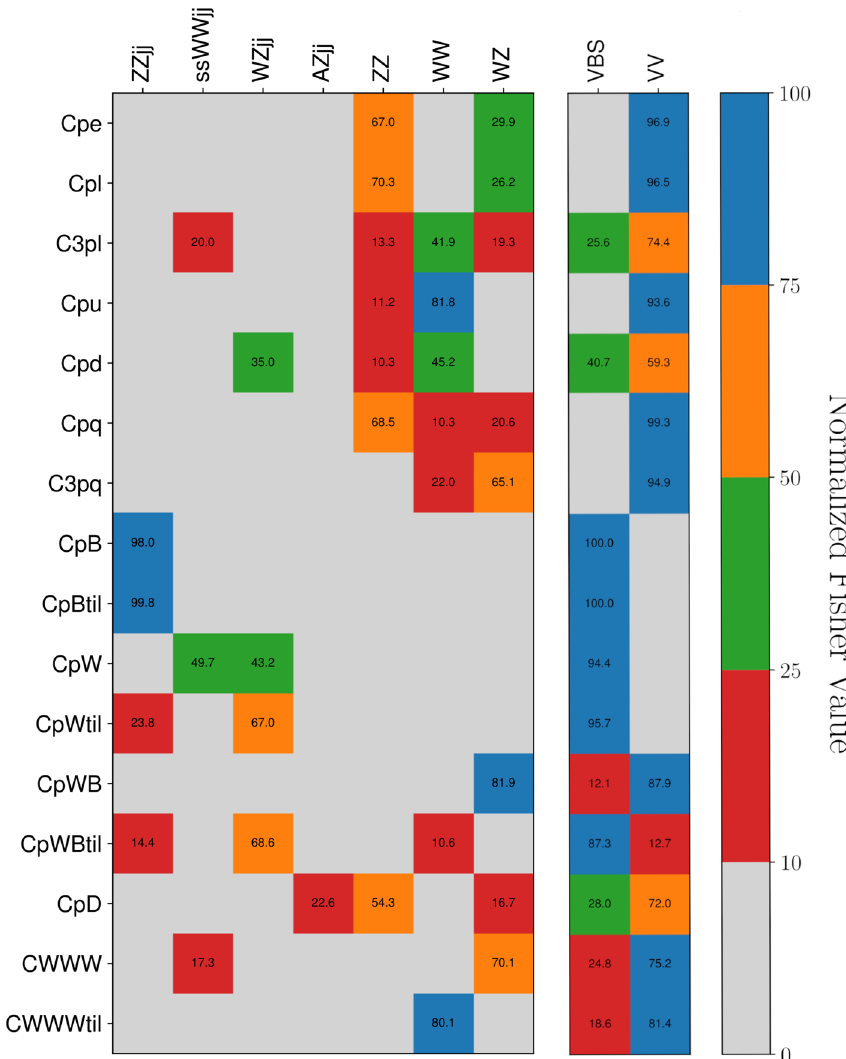
Fig. 12 The diagonal entries of the Fisher information matrix, I ii , evaluated for each of the coefficients that form our fitting basis. We display results separately for each channel (left) and when clustering all VBS and diboson datasets together (right panel). For those entries greater than 10%, we also indicate the numerical value in the heat